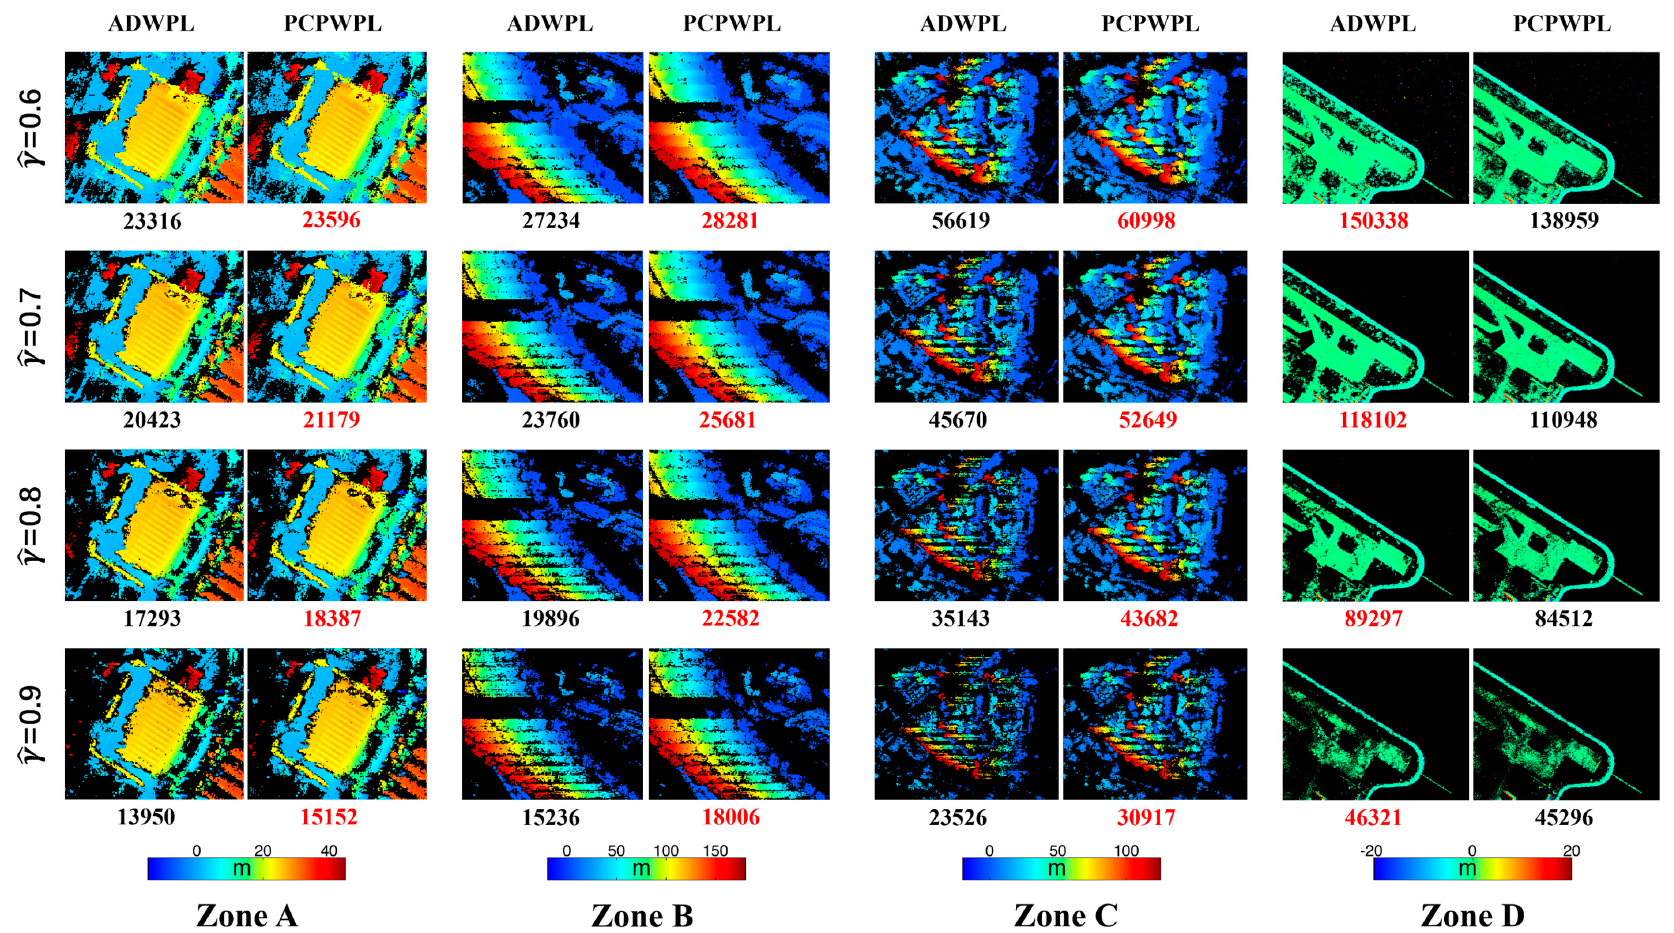
Figure 16. Height maps of the four zones A-D derived by DS extension from ADWPL and PCPWPL under di ff erent ˆ γ levels. The number of qualified points is annotated below each subplot with the red color indicating more points detected.